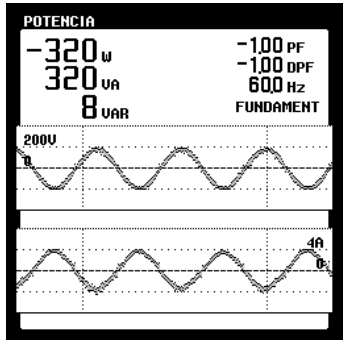
Figure 39. Output voltage–current oscillograms of the interconnected inverter with the MG.